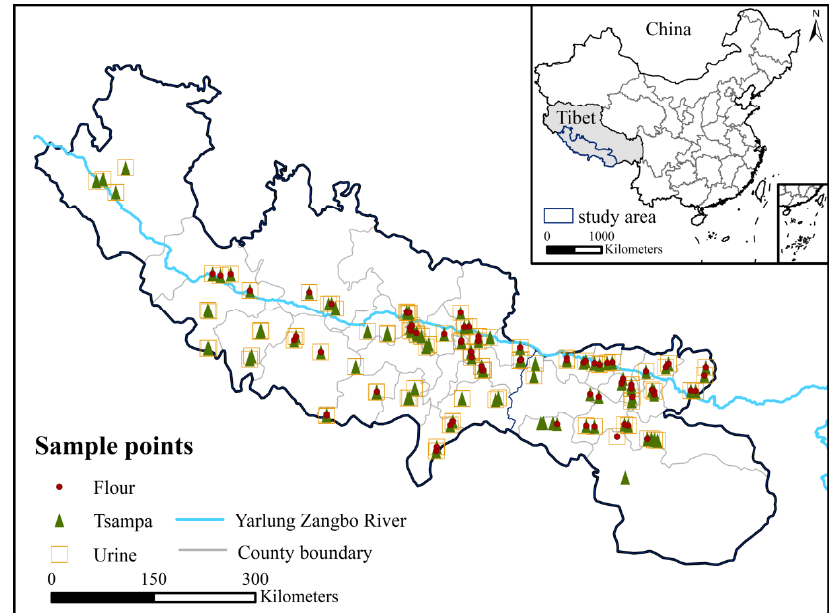
Figure 1. Sampling locations.